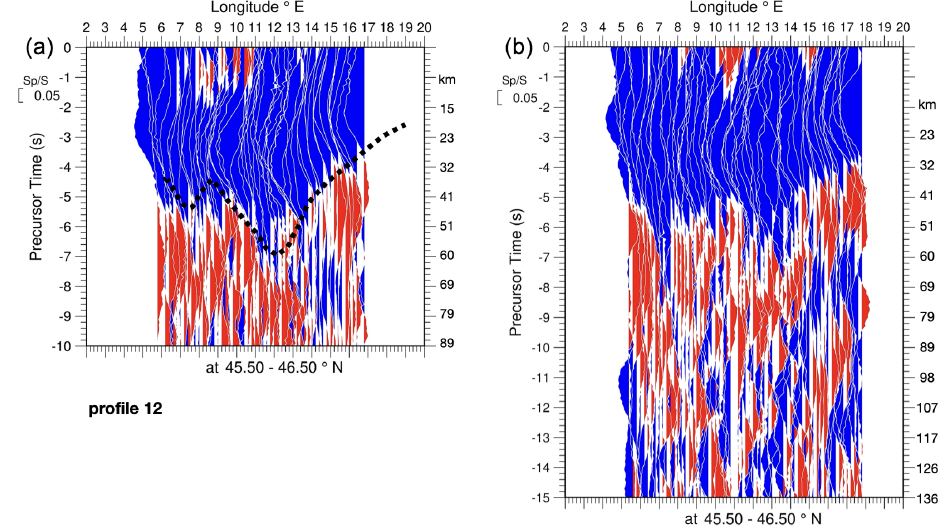
Figure 14. Profile 12. East–west profiles at 45.5–46.5 ◦ N, running within the Adriatic plate east of 8 ◦ E. The same dotted black line as in profile 10 (Fig. 12) is copied into (a) for